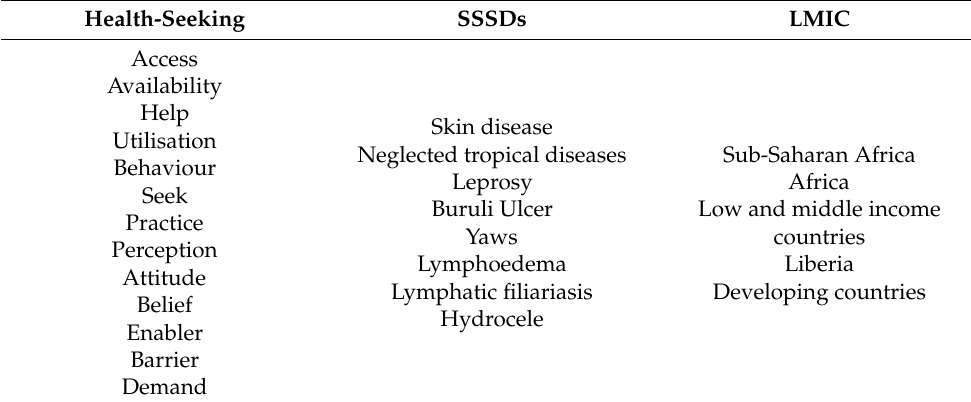
Table 1. Scoping review search